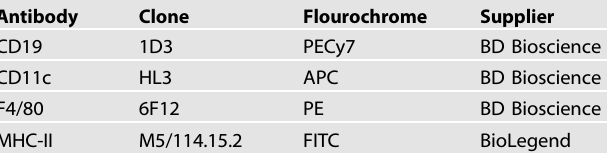
Table 1. Antibodies used to immunophenotyping peritoneal macrophages.